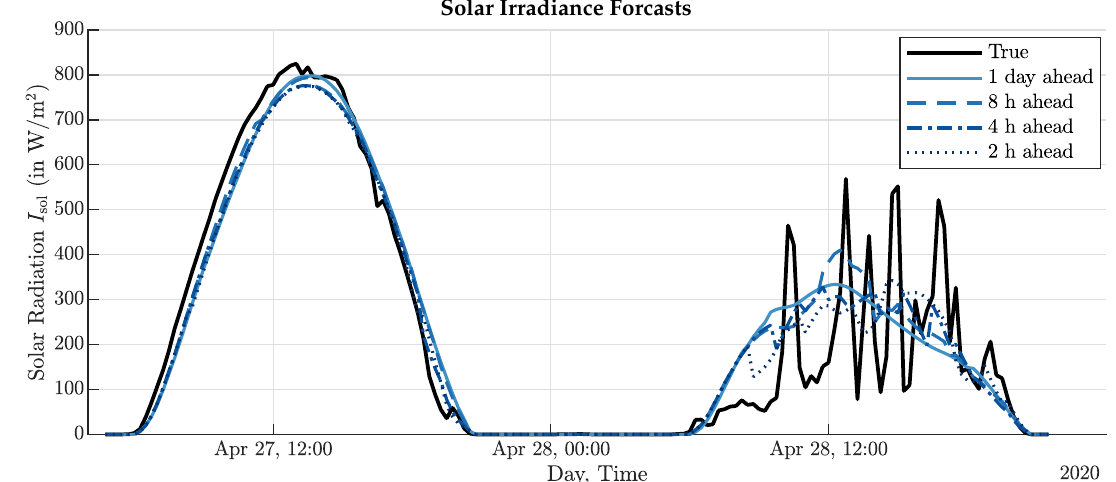
Figure 3. Exemplary forecasts (blue lines) and measurement (black line) of solar irradiance for two days in April 2020. For a sunny day (Apr. 27), the forecasts do not change significantly over time and are reasonably accurate, apart from a small delay. For a cloudy day (Apr. 28), the day-ahead forecasts smoothen the variations in I sol . The closer a forecast is, the better it resembles the ups and downs. However, even with only 2h ahead, the prediction error is still